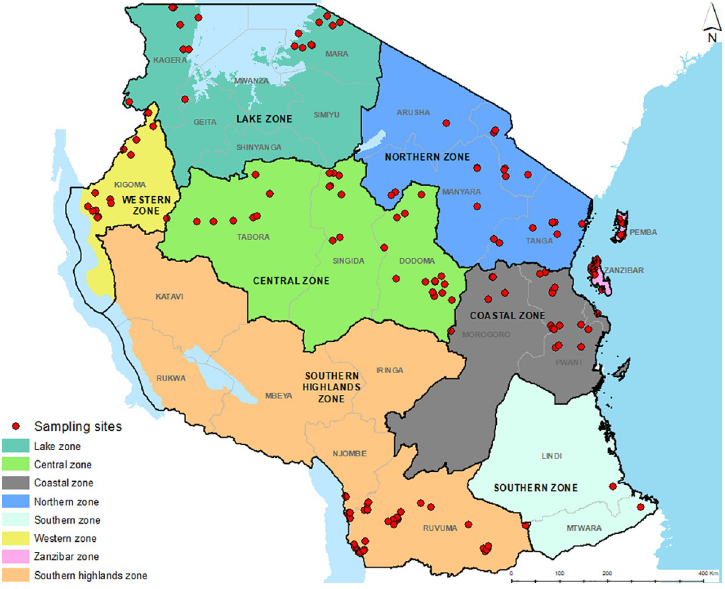
Fig 1. Location of 193 sites in Tanzania where cassava landraces were collected and key informant interviews